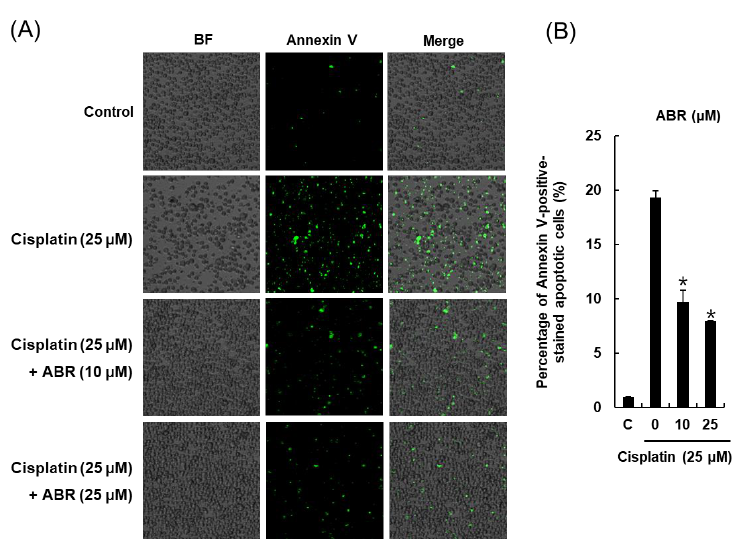
Figure 3. Protective effect of ABR on apoptosis in LLC-PK1 cells exposed to 25 μM cisplatin for 24 h by image-based cytometric assay. ( A ) Representative images for apoptosis detection (green) (Magnification: 4×); ( B ) Percentage of Annexin V-positive-stained apoptotic cells. Control cells were treated with the vehicle only (mean ± SD, * p < 0.05 compared to the control). The effects of 10 and 25 μM ABR on expression of phospho-JNK, JNK, phospho-p38, p38 and